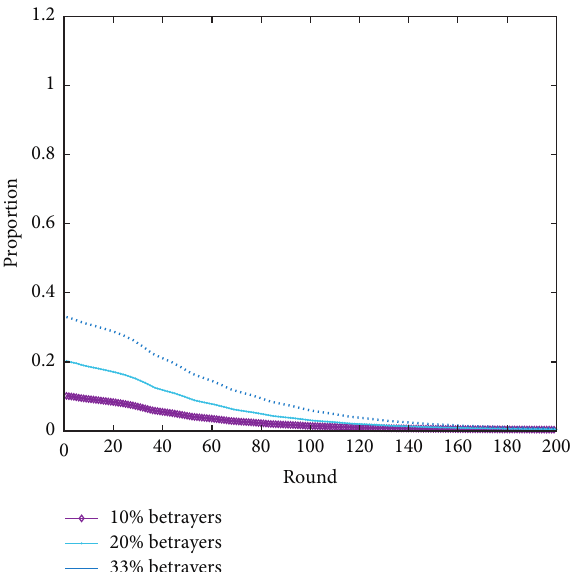
Figure 2: The initial proportions of malicious participants range from 10% to 33%.